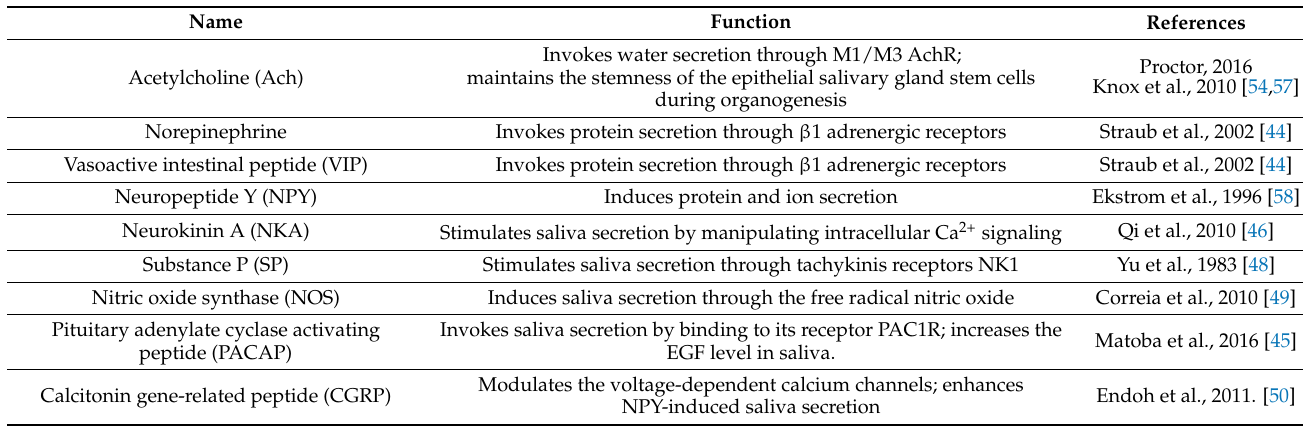
Table 2. Role of neurochemicals in salivary